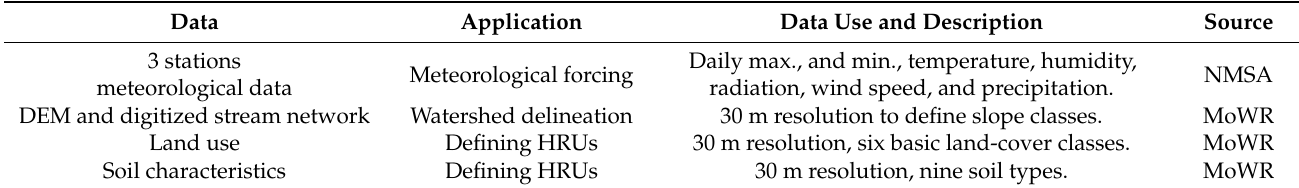
Table 1. Data source and description of data used to configure SWAT model.